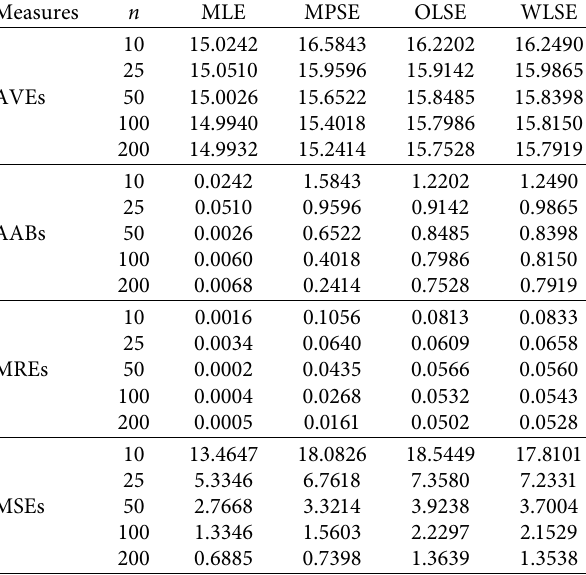
Table 6: Simulation results for β � 5 . 0.